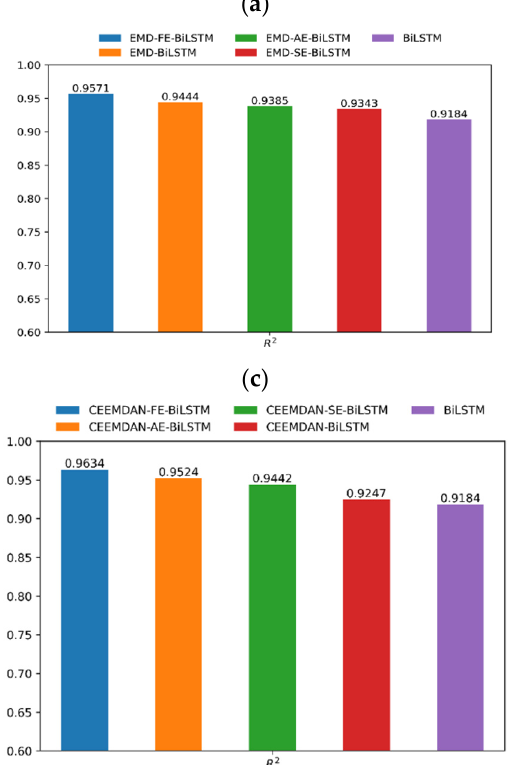
Figure 8. Comparison of goodness of fit of prediction models: ( a ) EMD decomposition; ( b ) EEMD decomposition; ( c ) CEEMDAN decomposition.